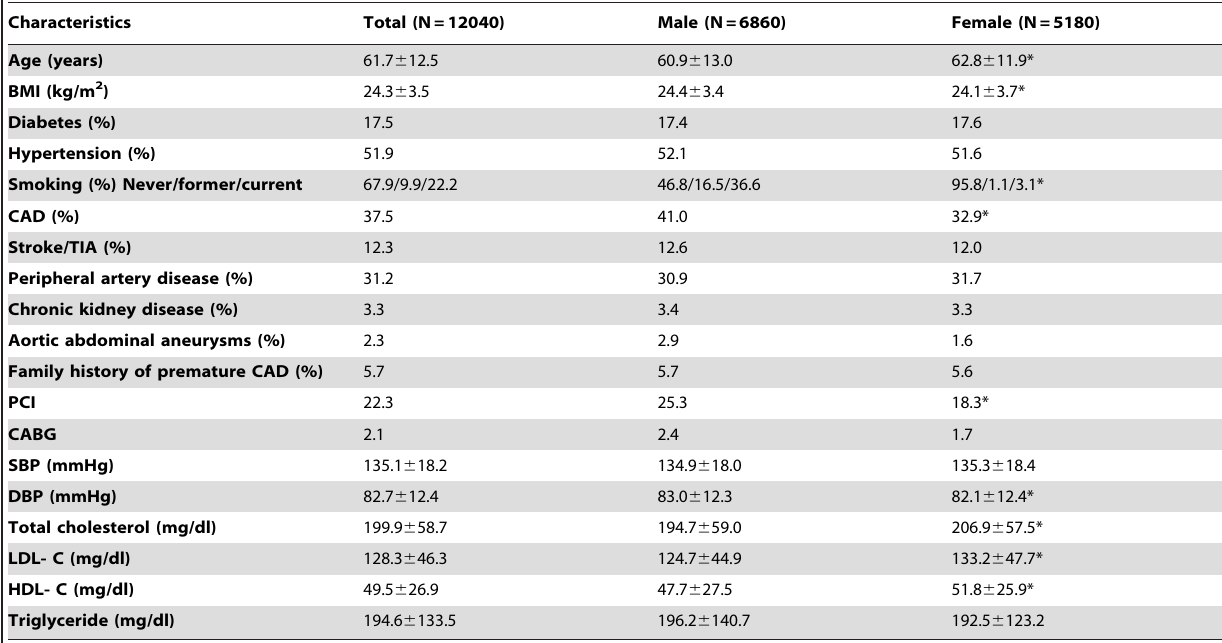
Table 1. Characteristics.